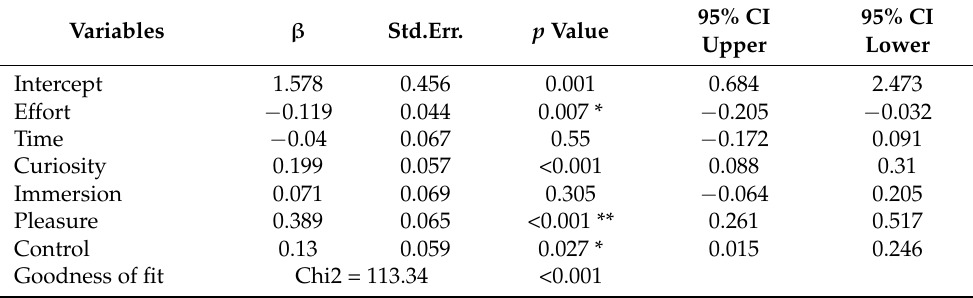
Table 8. Effect of mental effort and CA dimensions on satisfaction.